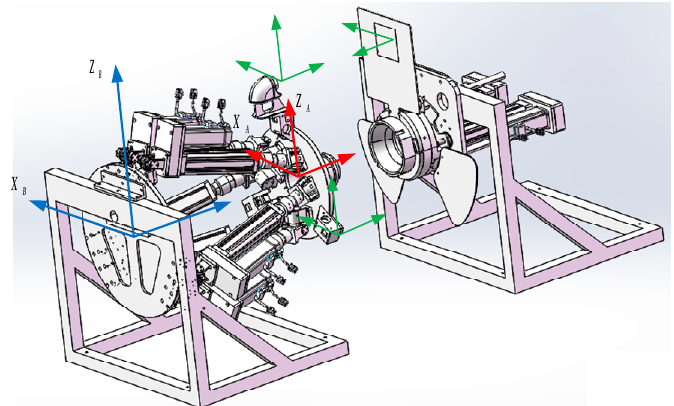
Figure 5. Transformation diagram of the docking system coordinate system.